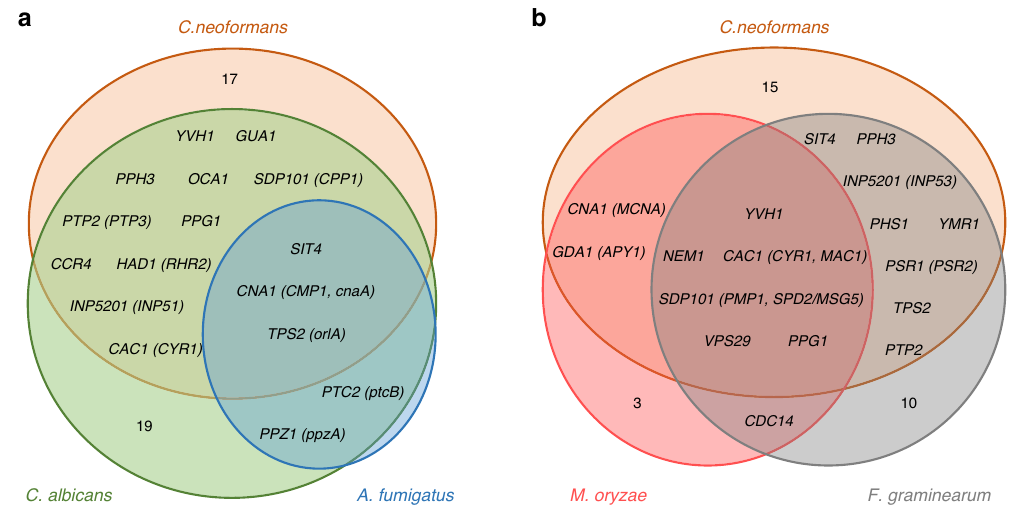
Fig. 8 Pathogenicity-related phosphatases in fungal pathogens. a Venn diagram showing the distribution of pathogenicity-related phosphatases in the human fungal pathogens C. neoformans , Candida albicans , and Aspergillus fumigatus . b Venn diagram showing the distribution of pathogenicity-related phosphatases in C. neoformans and plant-pathogenic fi lamentous fungi Fusarium graminearum and Magnaporthe oryzae